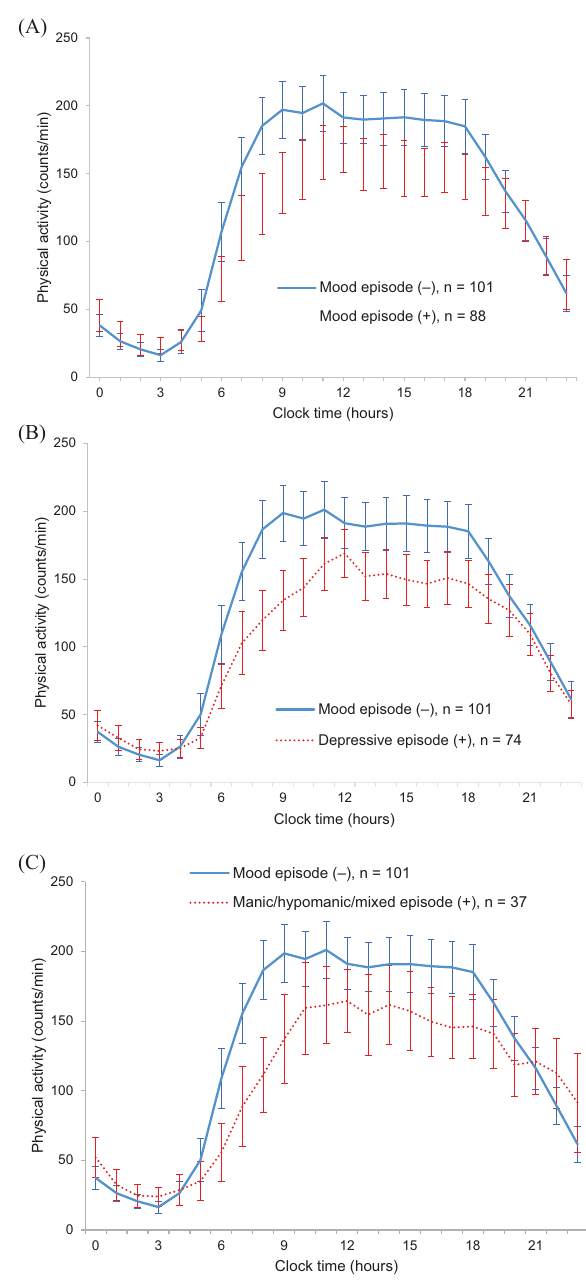
Fig. 1 Line graph of mean physical activity counts from midnight to 23:00 for 189 patients with bipolar disorder. The solid blue line indicates participants who did not experience mood episodes during the 12-month follow-up. The dotted red line indicates the participants who experienced mood ( A ), depressive ( B ), or manic/ hypomanic/mixed ( C ) episodes during the 12-month follow-up. Physical activity counts are plotted for each hour. Error bar presents 95% con fi dence